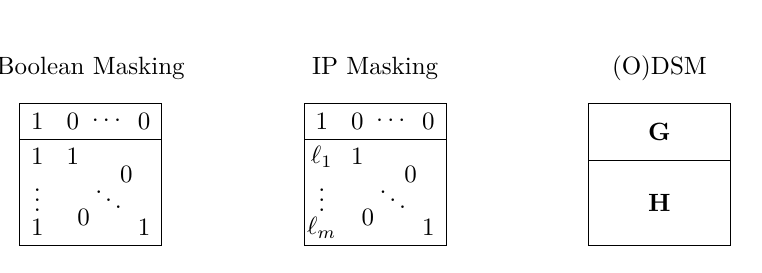
Figure 2: Matrix of Enc A for usual encoders. In each case the upper part has k rows, k being the number of encoded variables, and the lower part has m rows, the number of random